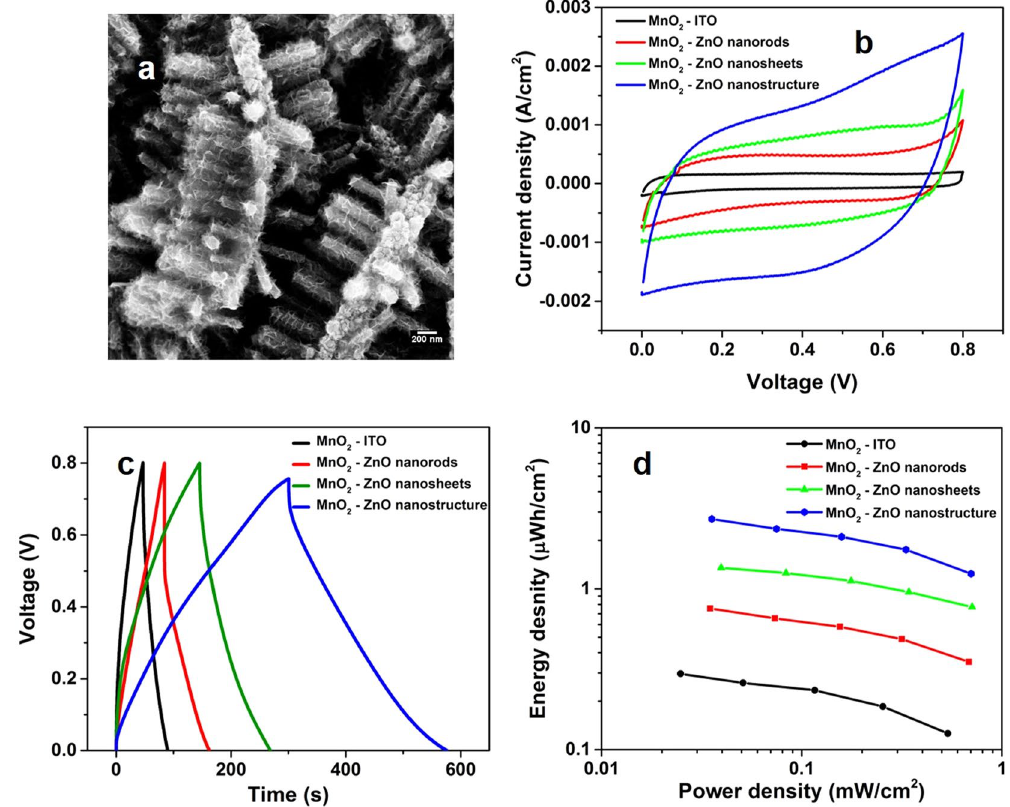
Figure 5. The hierarchical structure leads of a more than one order of magnitude increase in the energy storage capacity of a pseudocapacitor made with MnO 2 , compared to a flat morphology. ( a ) In the FESEM image, the conformal coating of the MnO 2 on the nanosheet-rod structure is clearly visible. ( b ) CV at 50 mV s − 1 scan rate, and ( c ) Galvanostatic charge-discharge curves of the different structures showing the effect of morphology. ( d ) The Ragone plots show the better performance of the hierarchical structure in both energy and power